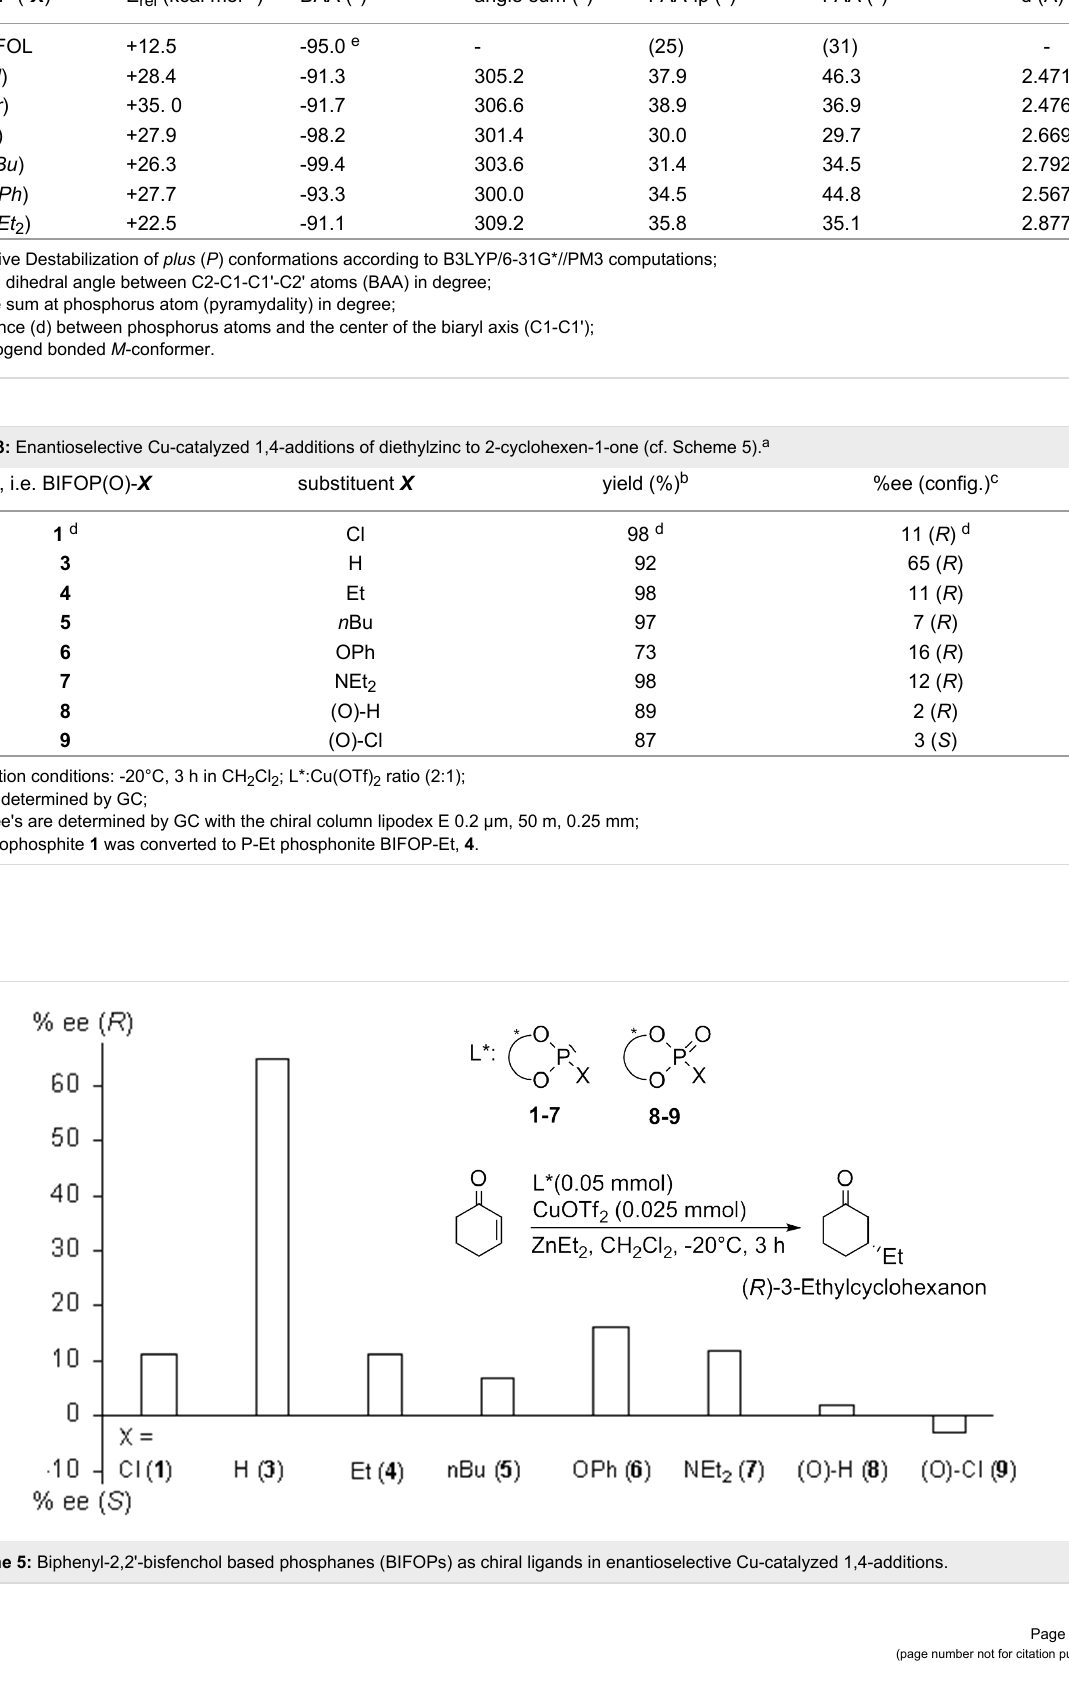
Table 2: X-ray structure geometries (cf. Scheme 4) and computed energies of BIFOL and BIFOP-X ( 1 – 7 ). BIFOP (- X )